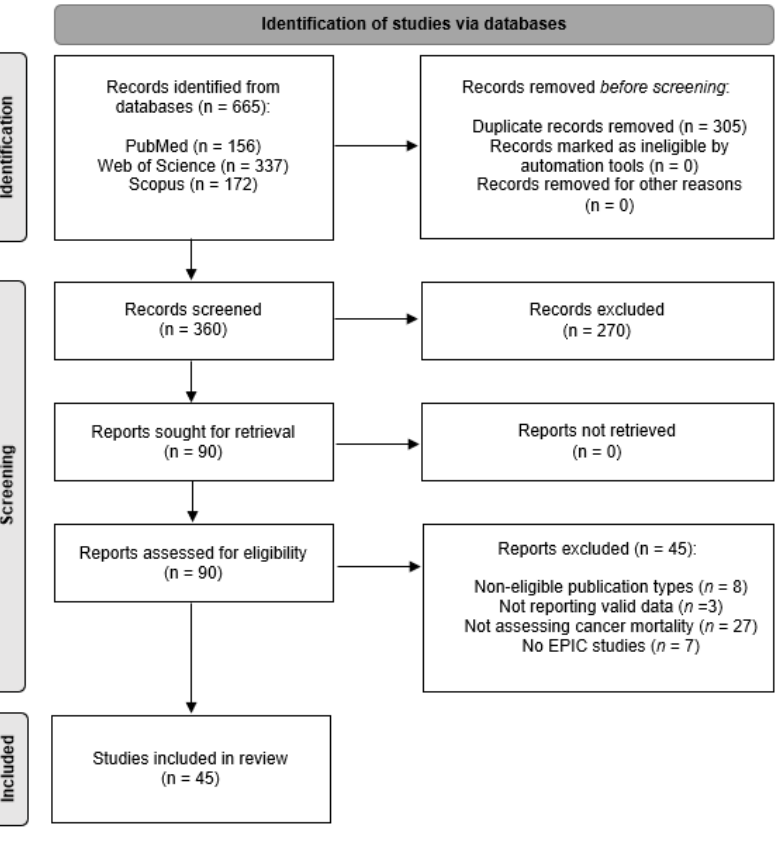
Figure 1. Preferred Reporting Items for Systematic Reviews and Meta-Analyses (PRISMA) flow diagram of study selection, inclusion, and exclusion.